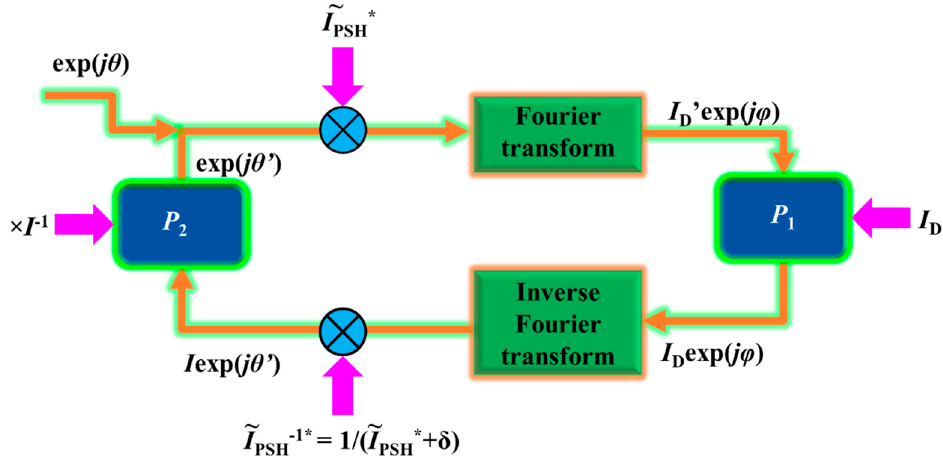
Figure 3. Schematic of the iterative algorithm for the generation of synthetic PSH. The symbol ~ above I PSH represents a Fourier transform operation, ⊗ represents a multiplication operation, and * represents complex conjugate.